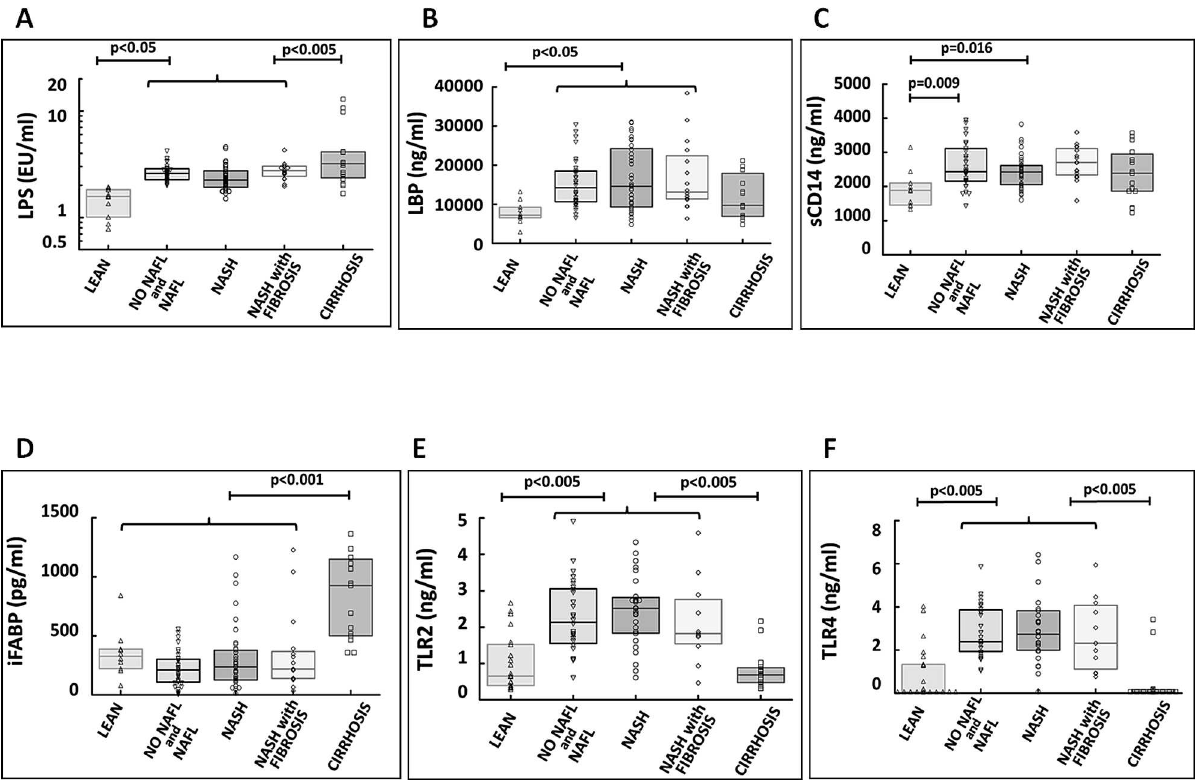
Fig 2. Plasmalevels of markersof endotoxemia and intestinal permeability across the different histological subgroups of patients. Five out of six markers investigated(with exceptionof iFABP), the concentrations in the lean controls was significantly lower than in the NAFLD subgroups. For 4 markers (LPS, iFABP, TLR2 and TLR4) plasma levels in cirrhosispatients was significantly different from NAFLD subgroups. Brackets indicate that analysisof multiple subgroups with cirrhosis or lean group (as indicated) was statisticallyrelevant for each subgroupseparately. When comparisonwas made betweenthe groupsincludedin the brackets there was no statistical difference (Kruskal-Wallis One Way Analysis of Varianceon Ranks). Only if p < 0.05, this was considered significantand indicatedin the figures. (NASH and NASH with fibrosis) compared to patients with NAFL (Table 1). High density